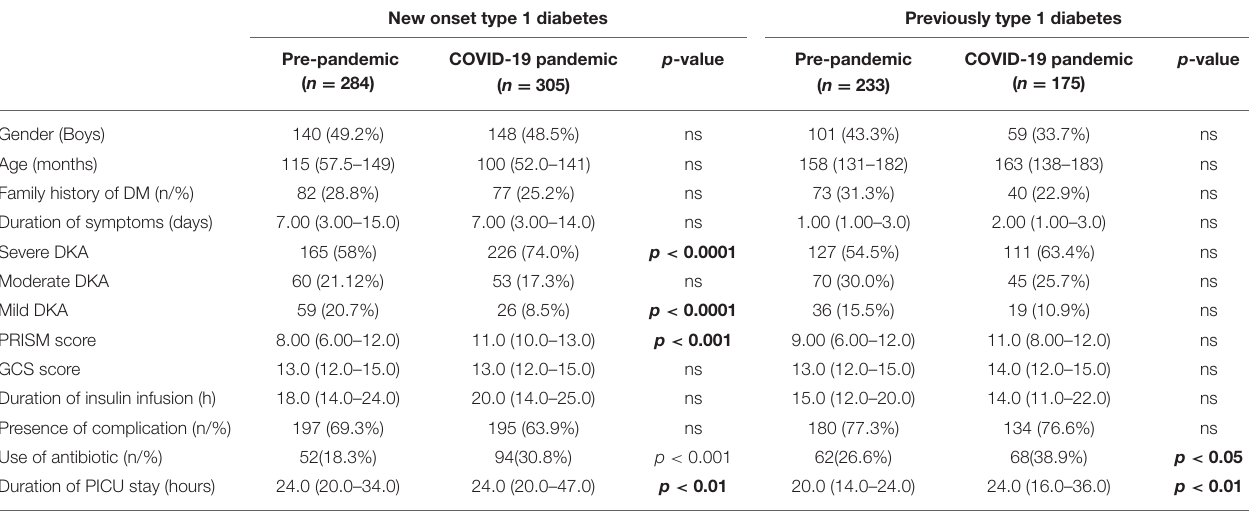
TABLE 3 | Clinical features of new onset type 1 diabetic children with DKA during pre-pandemic and COVID-19 pandemic